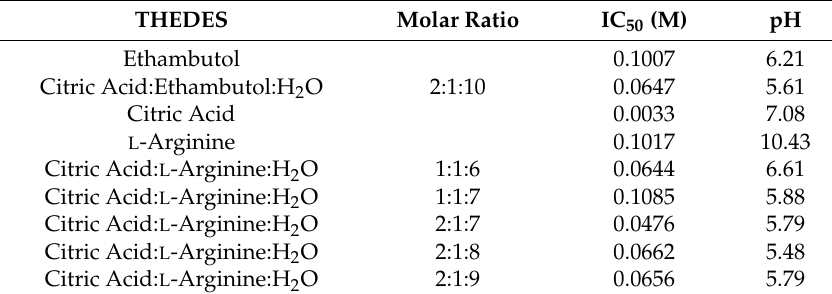
Figure 6. IC 50 representation, based on cell viability obtained in Caco-2 cell line. Table 3. IC 50 of THEDES and raw materials in Caco-2 cell line.